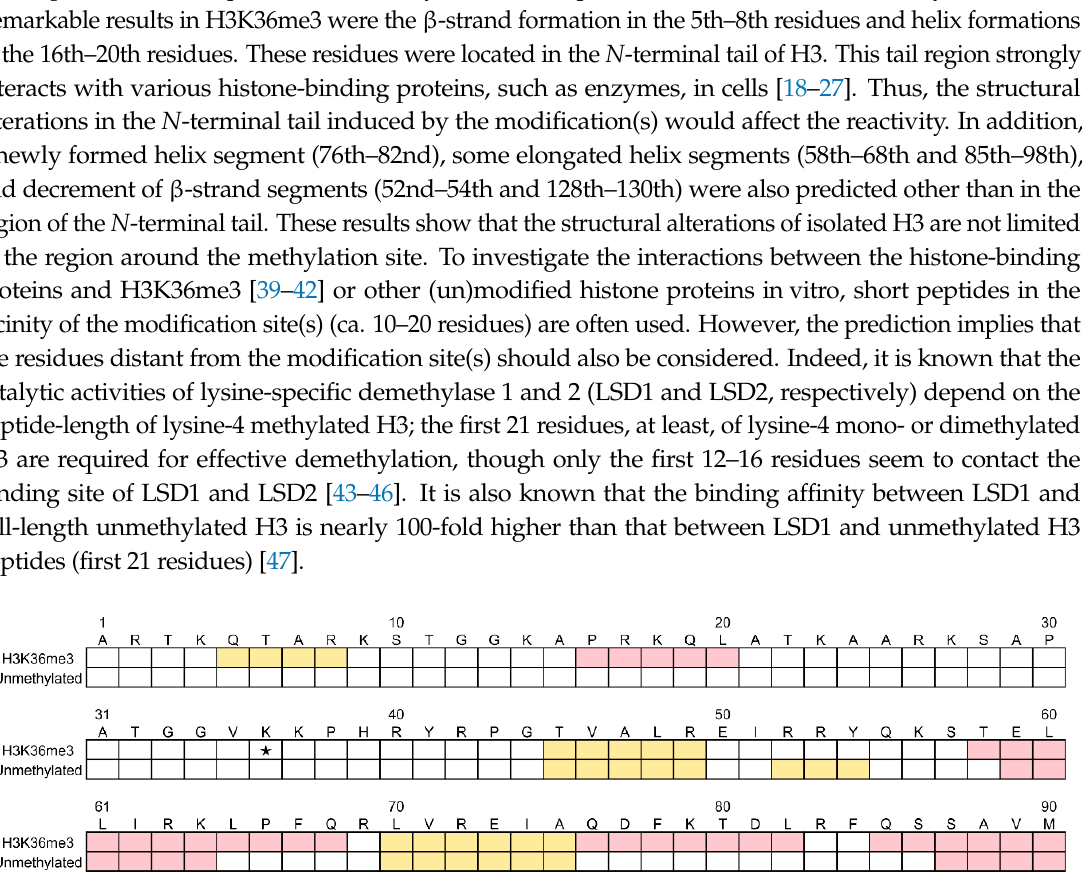
Table 1. The secondary structural contents of H3K36me3 and unmethylated H3, obtained using the SELCON3 program.